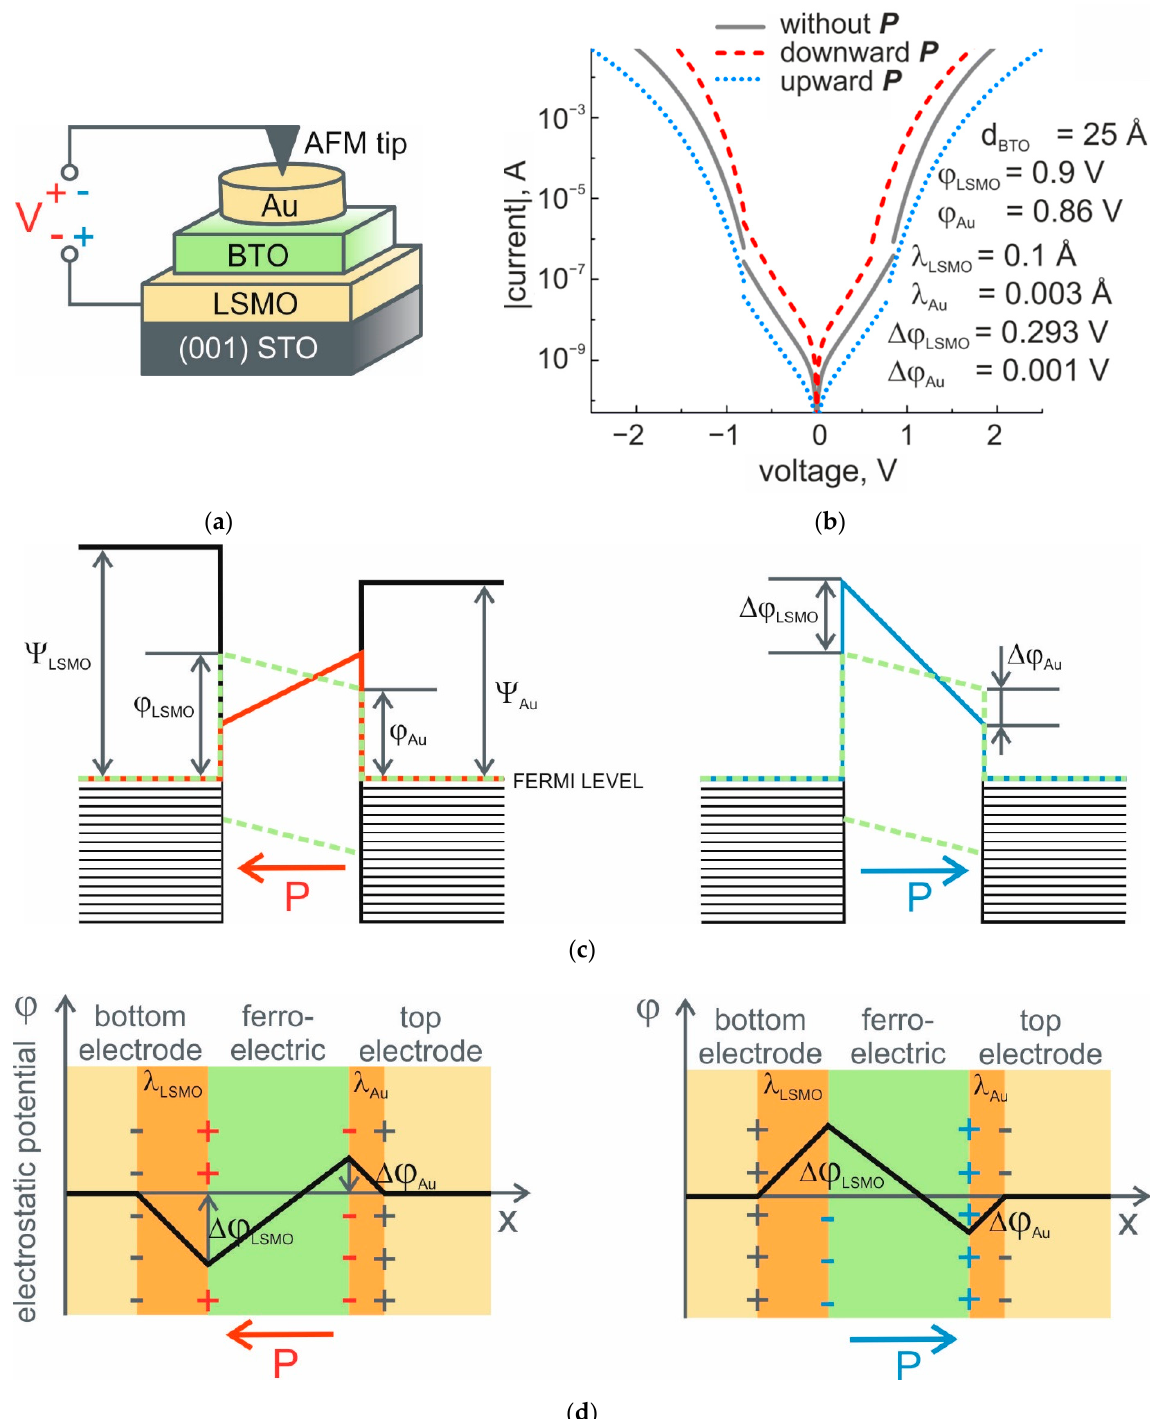
Figure 2. Conductive AFM studies of TER. ( a ) Schematic illustration of a STO/LSMO/BTO/Au FTJ and a method for investigation of resistive properties with AFM tip placed on top of gold electrodes; ( b ) simulated I - V curves of FTJ with dissimilar electrodes and polarization charge compensation taken into account. The simulation is based on the electrostatic model and the Simmons approach for intermediate and high-voltage ranges; ( c ) energy diagram of the barrier between dissimilar electrodes at different polarization orientations; ( d ) schematic representation of the residual uncompensated potential, φ (x) , for uniformly polarized FE film between two dissimilar electrodes with effective screening lengths λ LSMO and λ Au for two polarization states. Left to right: for polarization pointing to the left and for polarization pointing to the right.